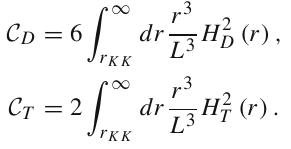
therefore denoted as U ¯ symmetry. Note that the 4–8/ 8 strings has zero length in this D4/D8 configuration, the fundamental fermions are therefore massless which correspond accordingly to the light flavoured quarks in QCD. In this sense it motivates us to name these flavour branes as “light flavour branes”. As shown in Table 1, the quarks and anti-quarks live on the separate position of X 4 . broken spontaneously since the geometry of the D4 bubble bottom of the bulk as illustrated in Fig.